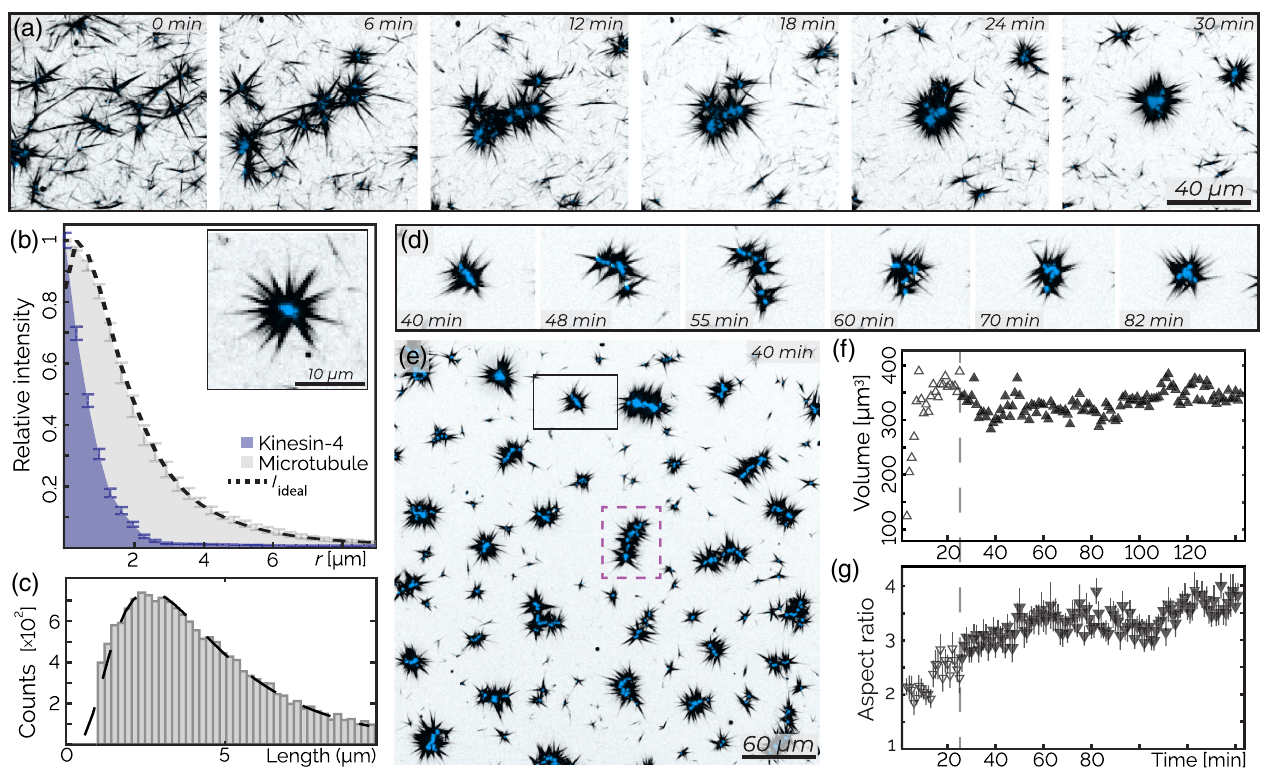
FIG. 1. Active asters: Asters self-organize and reconfigure. (a) Kinesin-4 induces rapid assembly of asters. (b) The density profile of microtubules (gray) radially averaged from the z projection of an aster. Predicted structures I (dotted black line) based on end-bound ideal kinesin-4 motors, given the measured density profile of kinesin-4 (blue). Bars are the standard error averaged over three similar radial asters. Inset: aster with approximate radial symmetry. (c) Microtubule polydispersity (gray bars) is described by a log-normal distribution (dashed black line, M ¼ 1 . 4 , S ¼ 0 . 6 , mean 4 . 9 μ m, mode 2 . 8 μ m). (d) Temporal rearrangement of an aster. (e) A large field of view shows fully formed asters. The dashed purple line highlights a wormlike structure. (f) The mean aster volume as a function of time. Open shapes indicate the aster formation regime. (g) The mean major/minor moment ratio of asters over time. Bars represent standard deviation. All images are z projections over 6 . 5 μ m; the sample contains 200 nM kinesin-4 (blue) and 400 nM tubulin